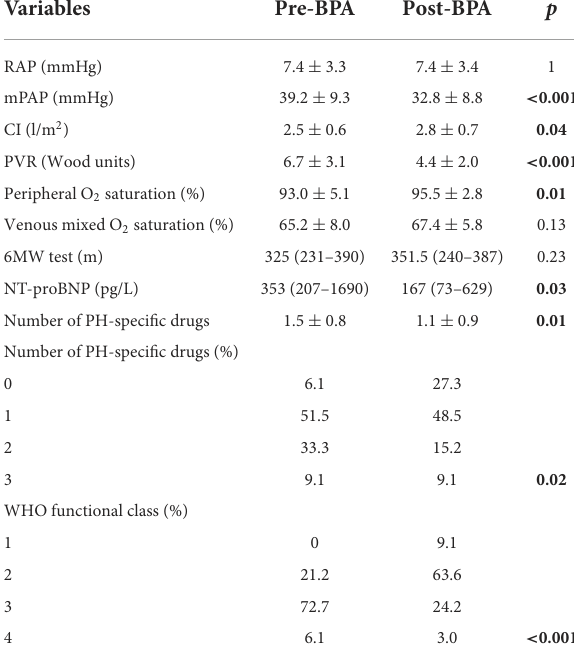
TABLE 4 Hemodynamic and clinical changes after BPA in 33 patients aged ≥ 70